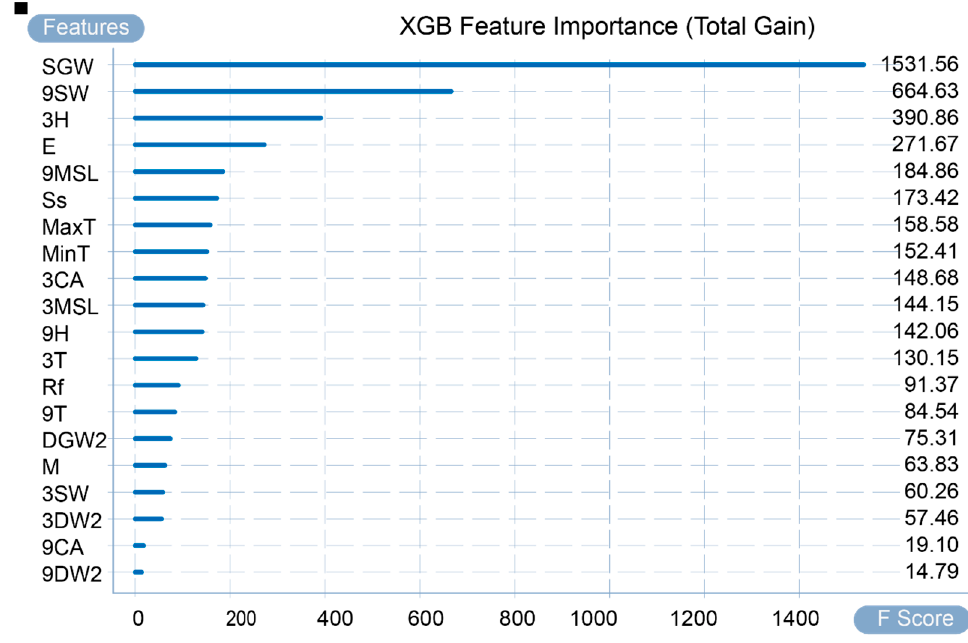
Figure 8. Feature importance for total gain.